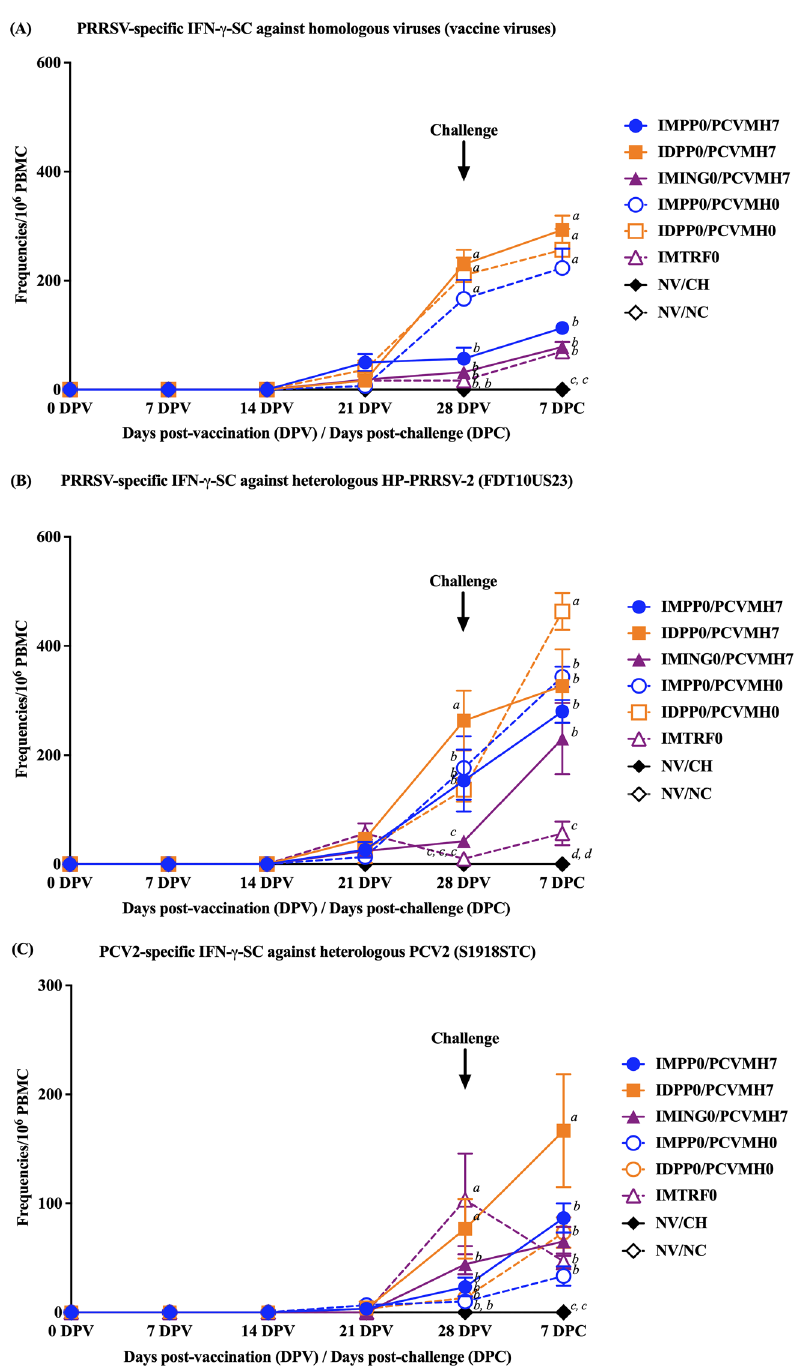
Figure 4. Frequencies of virus-specific IFN-γ-SC after stimulation with ( A ) homologous viruses (vaccine viruses), ( B ) heterologous HP-PRRSV-2 (FDT10US23) virus, and ( C ) heterologous PCV2 (S1918STC) virus. Values expressed as mean ± SEM. The results were compared using two-way ANOVA for multiple comparisons. Different lowercase letters (a–d) indicate significant differences between treatment groups ( p < 0.05) for each